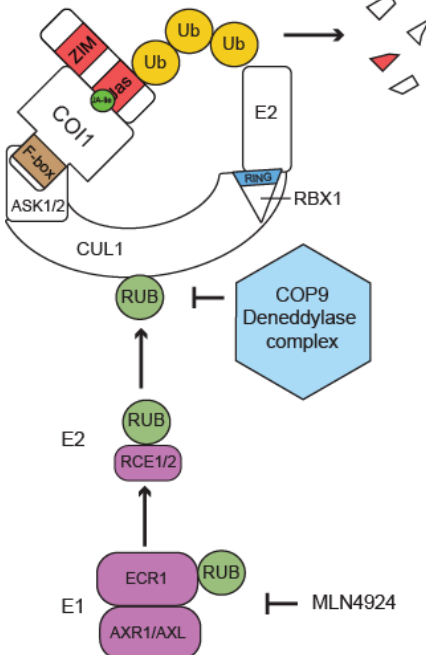
Figure 4. Regulation of SCF COI1 by Nedd8/RUB. The activity of SCF COI1 is modulated by cyclic attachment and removal of the ubiquitin-like modifier (UBL) Nedd8/RUB to the CUL1 subunit of the SCF complex. Accordingly, plants carrying mutations in the genes encoding components of the neddylation machinery (E1: ECR1/AXR1/AXL; E2: RCE1/2) or in the COP9 deneddylase signalosome complex are also affected in JA signaling. Defects in the RUB-conjugation pathway can also be mimicked using the E1-specific inhibitor MLN4924